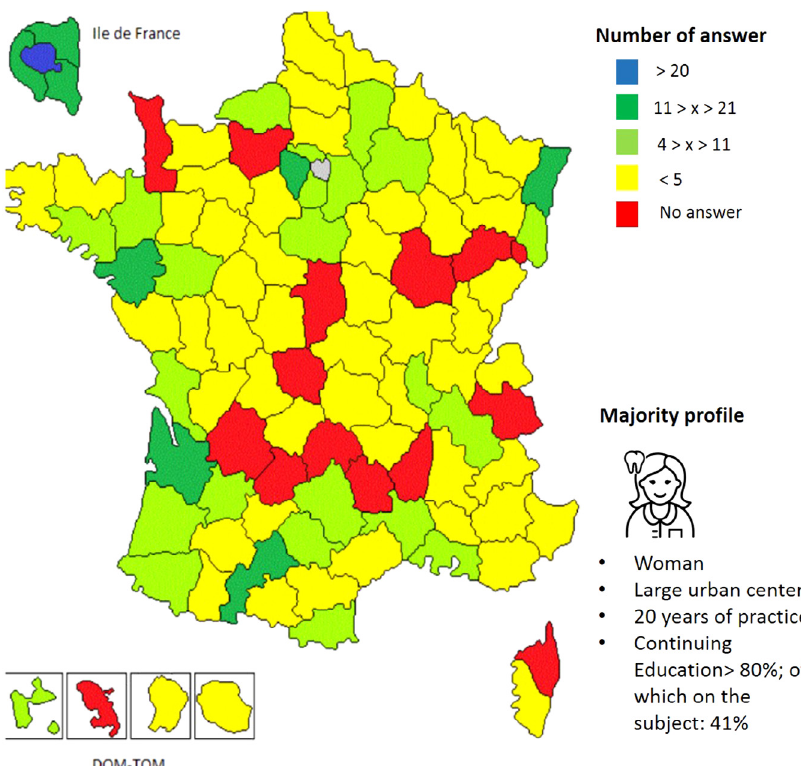
Fig. 2. Demographic aspect of the cohort of dentists. Map of France representing the spatial distribution of responses. Red zone: no response; yellow zone: less than 5 responses; light green zone: between 4 and 11 responses; dark green zone: between 11 and 20 responses and blue zone: more than 20 responses. The majority pro fi le of responding dentist surgeons was: woman, in large urban zone, with 20 years of practice and who follows continuing